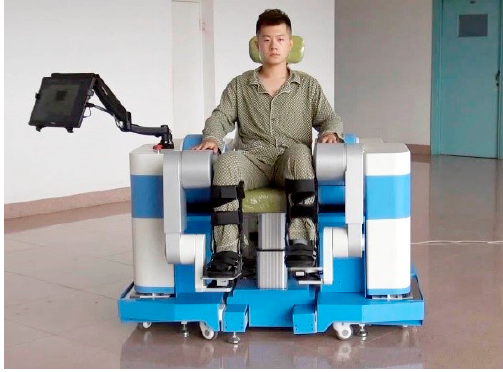
Figure 1. The LLR-II Rehabilitation.